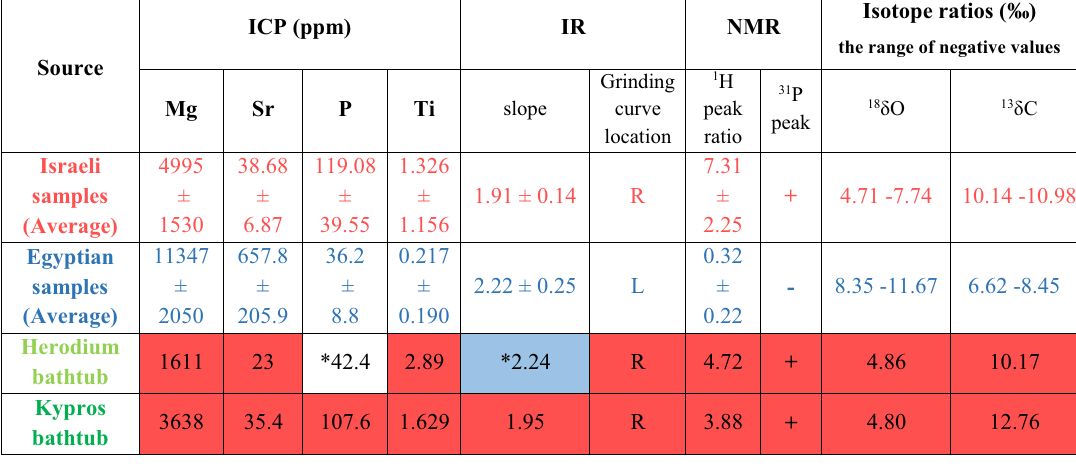
Table 3. Summary of results. Israeli samples in red, Egyptian samples in blue. The color coding of the cells in the table showing bathtub samples indicates their similarity to the corresponding values of the "known" Israeli and Egyptian samples. *see